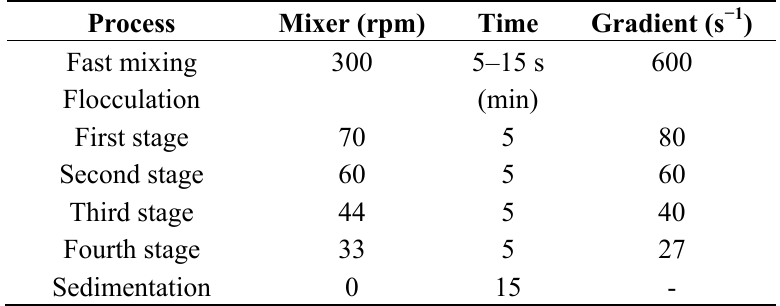
Table 3. Jar Test operating